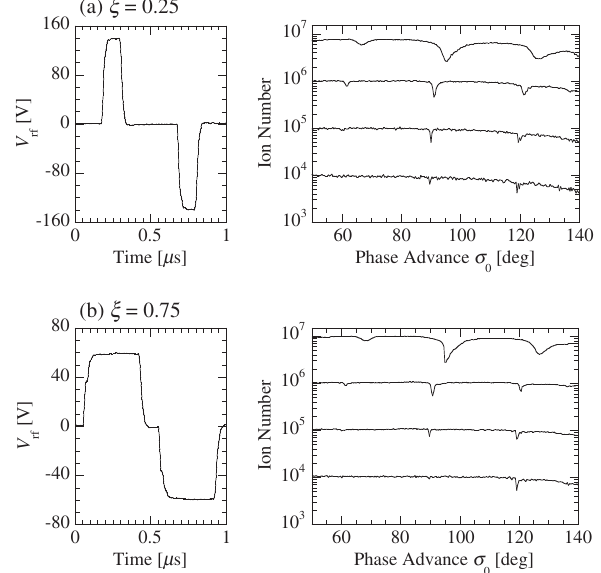
FIG. 8. Ion-loss distributions measured in S-POD with doublet focusing waveforms of different quadrupole filling factors. The drift-space ratio is fixed at ζ ¼ 1 while we consider two quadru- pole filling factors: (a) ξ ¼ 0 . 25 and (b) ξ ¼ 0 . 75 . The left panels show the rf waveforms generated by the S-POD power supply when σ 0 is adjusted to 90°. The storage period of ions in the LPT is fixed at 10 ms.